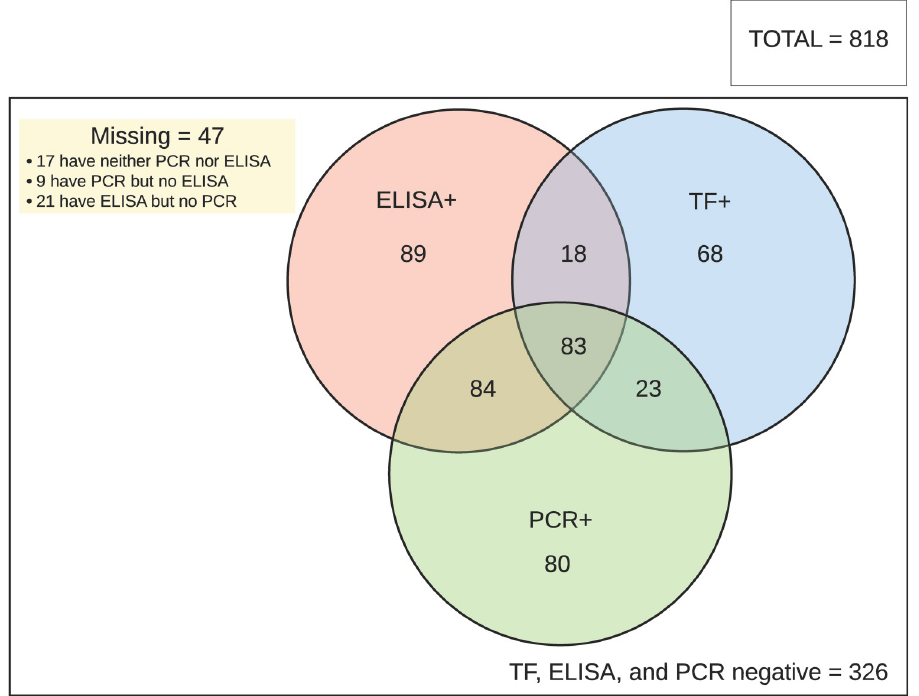
Fig 3. Co-occurrence of clinical and laboratory findings in children aged 1–9 years in Nauru, July 2019. Abbreviations: TF, trachomatous inflammation—follicular; ELISA, enzyme-linked immunosorbent assay; PCR, polymerase chain reaction.